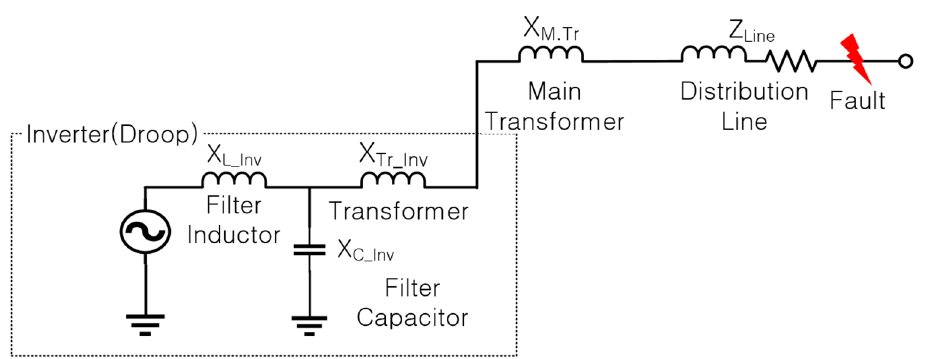
Figure 6. Equivalent circuit for fault current calculation of inverter.